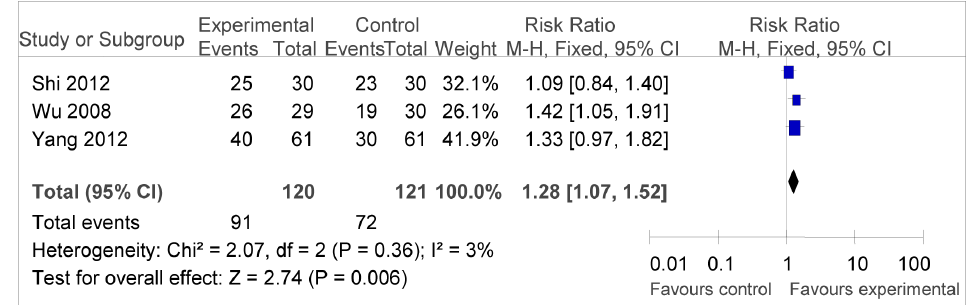
Figure 4. Forest plot of the comparison of disease control rate (DCR). P values are from P for the effect modification evaluation of heterogeneity within or across the groups of regimens. CI, confidence interval; RR, risk ratio; DC/CIK, DC-CIK immunotherapy; Chemo, chemotherapy; Con, control group; Exp, experimental group. A fixed-effect meta-analysis model (Mantel-Haenszel method) was used.